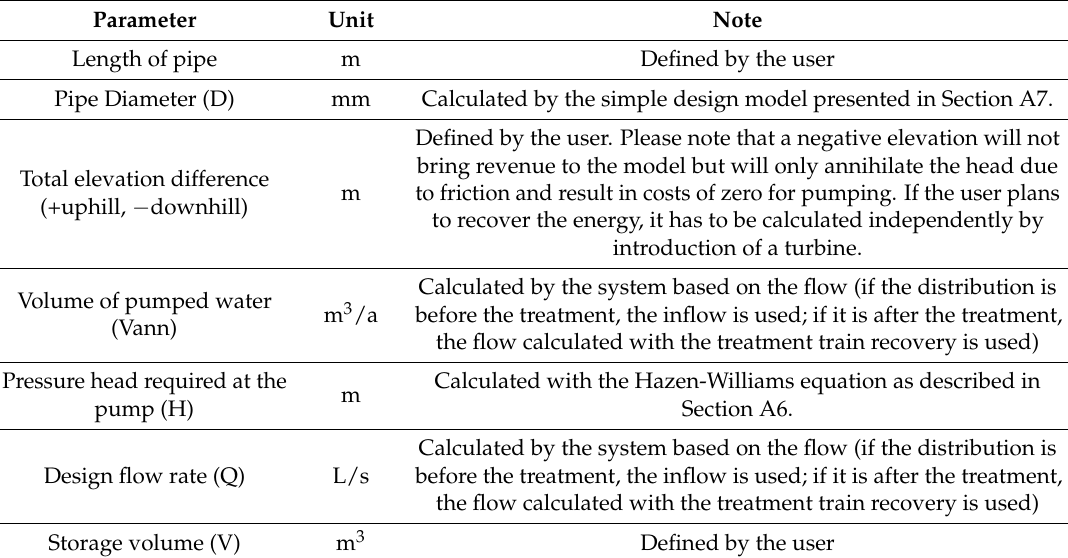
Table A3. Input parameters required for the calculation of the distribution